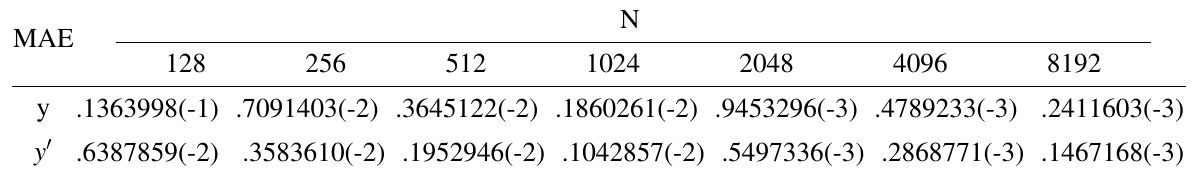
Table 4 Maximum absolute error in y ( x ) = sin 2 ( x